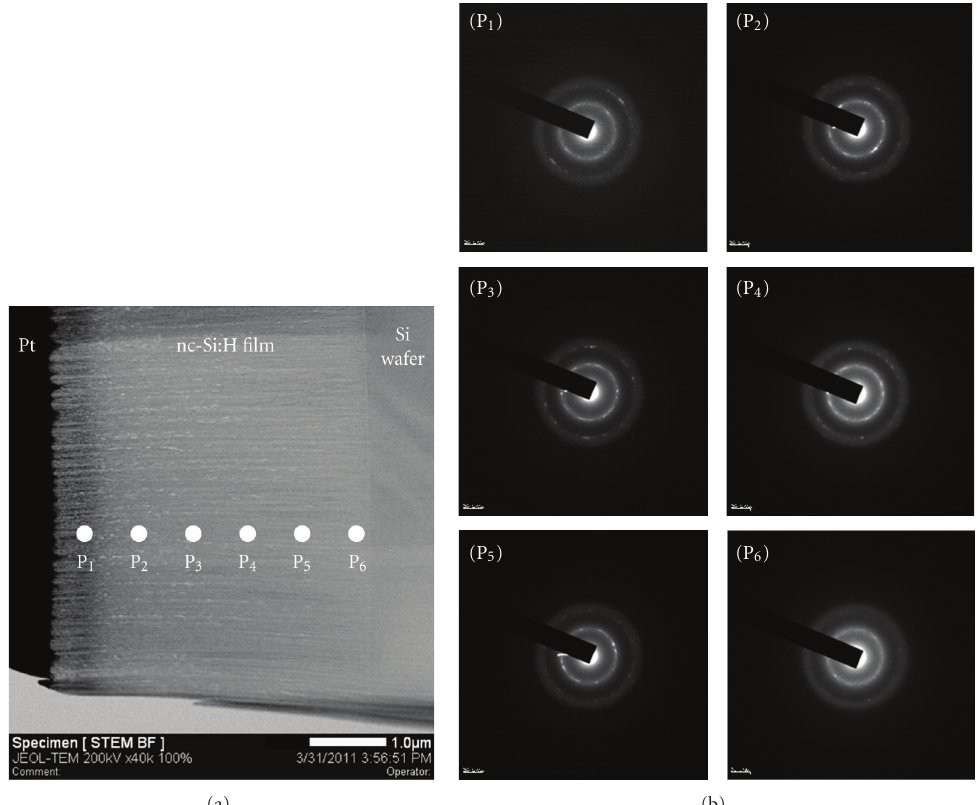
Figure 6: (a) Cross-section STEM image of the nc-Si:H thin films. Arrow m indicates the interface between the substrate (Si-wafer) and nc-Si:H films. (b) Electron microdi ff raction patterns were recorded at positions P 1 ∼ P 6 in (a).